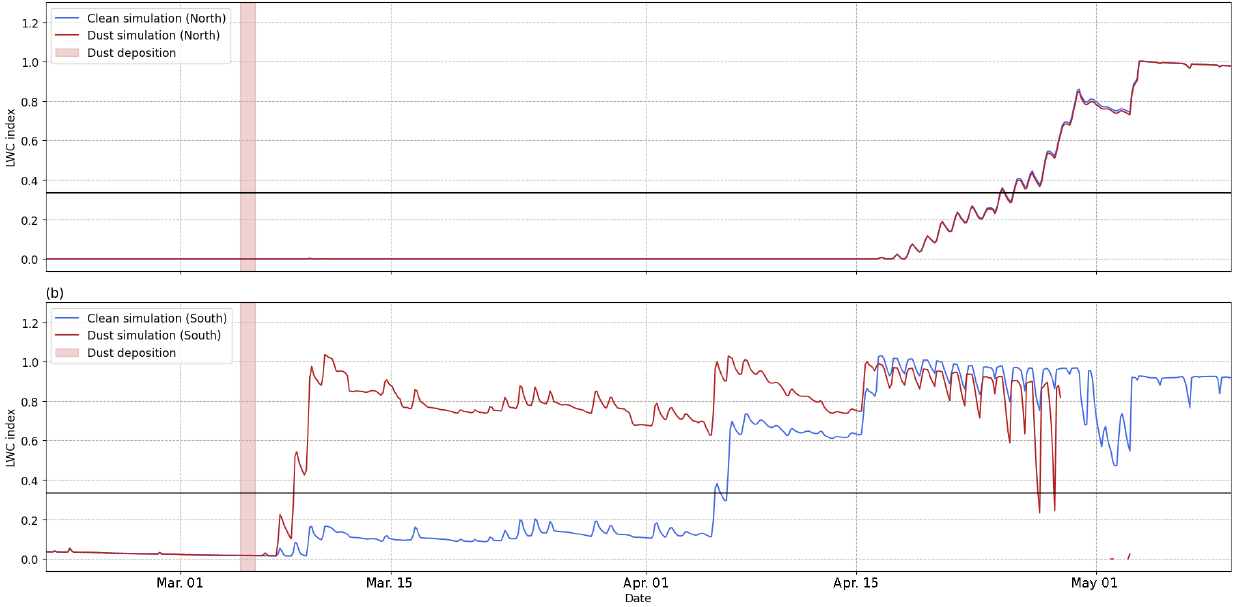
Figure 8. LWC index for member 8 of both dust and no-dust simulations on a 40 ◦ steep (a) north-facing and (b) south-facing slope. The horizontal black line shows the threshold of